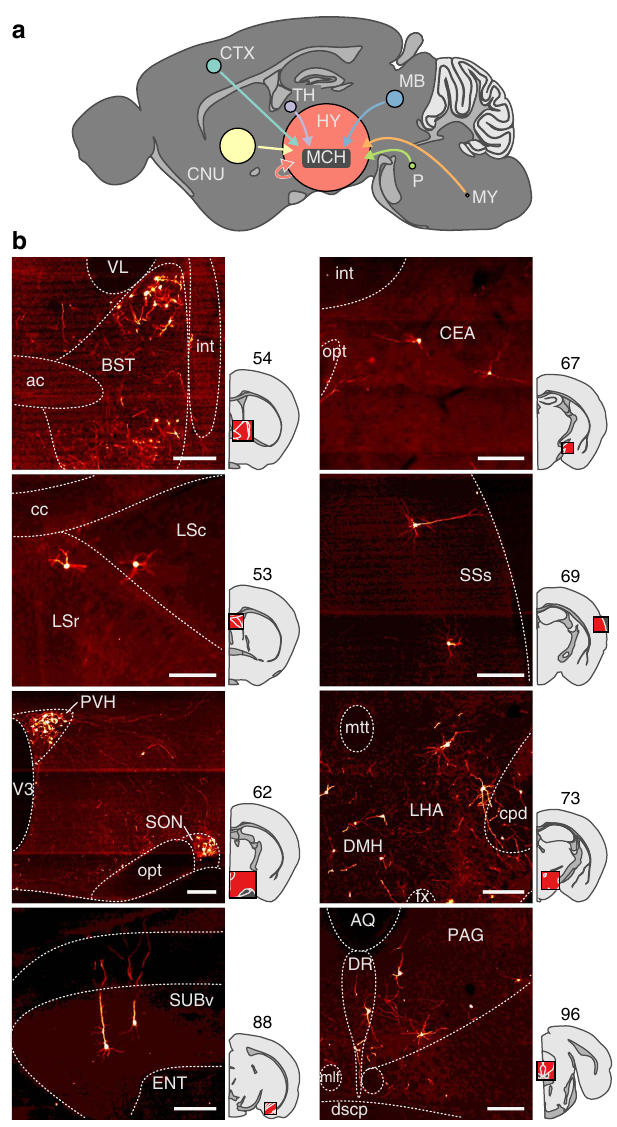
Figure 4 | Coarse-grained whole-brain mapping of neural inputs to MCH cells. ( a ) Scheme showing relative contributions of seven large-scale